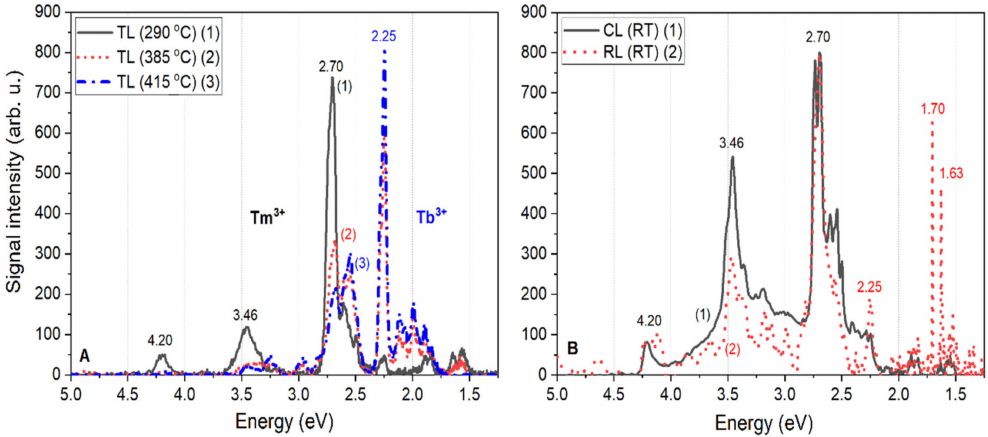
Figure 6. Luminescence spectra measured for double-doped LiMgPO 4 :Tb,Tm crystals under di ff erent modes of stimulation: TL ( A ) and CL and RL ( B ). Note that the CL and RL emission spectra were normalized, and thus their intensities should not be directly compared to the intensities of the TL emission